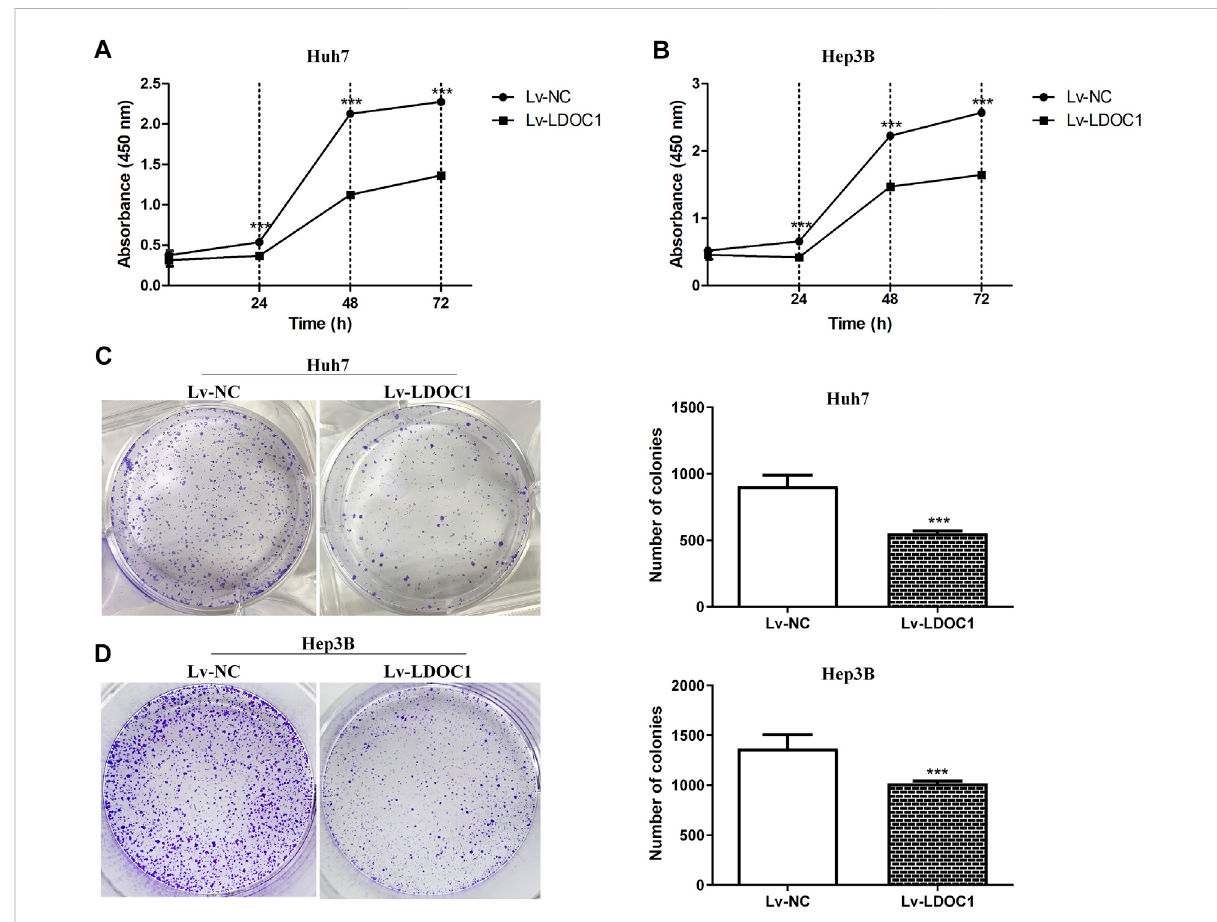
FIGURE 6 Proliferation and colony formation assays for Huh7 and Hep3B cell lines after LDOC1 overexpressing. Graphs of (A) Huh7 and (B) Hep3B cell linesforproliferationassayswithLv-NCandLv-LDOC1at0,24,48,and72 h.Graphsof (C) Huh7and (D) Hep3Bcelllinesforcolonyformationassays with Lv-NC and Lv-LDOC1 at 10 days ***, p <